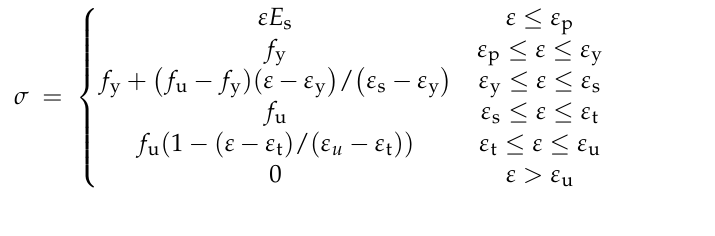
Table 7. Parameters of CDP model. Parameters